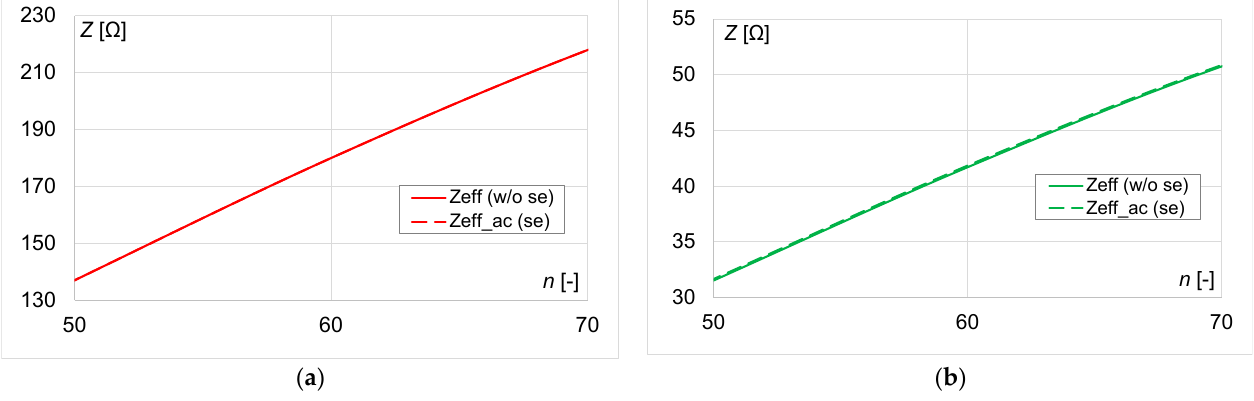
Figure 6. Load impedance for the cases with and without skin effect at 1 MHz for the large coil at ( a ) h = 0.0125 m; ( b ) h = 0.025 m. In Figure 7, the resistances of coils are presented ( r = 0.01 m and r = 0.025 m). Skin effect increases coil resistance by approx. 30% for small and large coils and regardless of the number of turns.